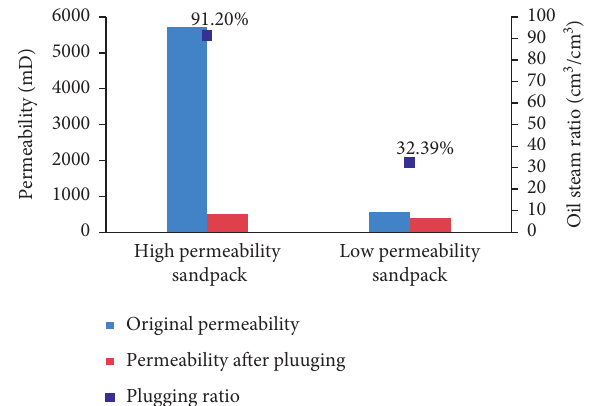
Figure 6: Comparison of plugging ratio before and after plugging with different-permeability sand pack models.